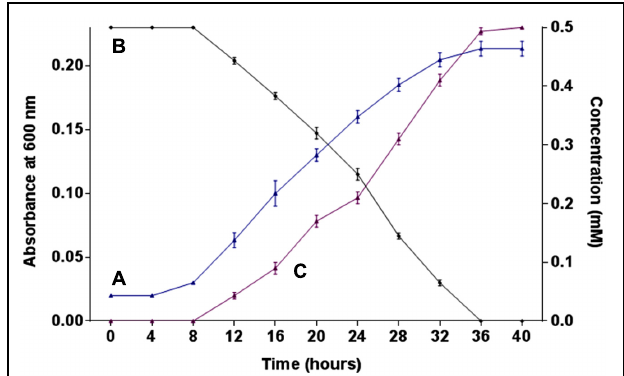
FIGURE 1 | Growth, degradation, and nitrite release. (A) Growth of strain SPG in minimal medium containing 0.5 mM 2NB; (B) 2NB degradation by strain SPG; and (C) release of nitrite ions during bacterial degradation of